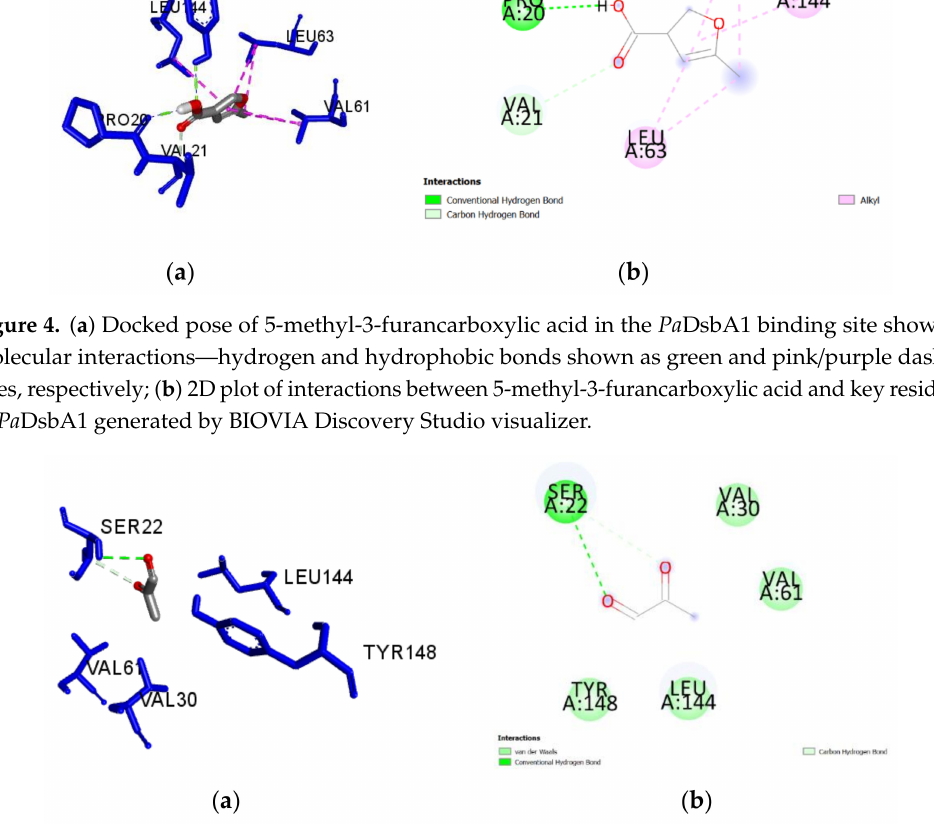
Figure 5. ( a ) Docked pose of methylglyoxal in the Pa DsbA1 binding site showing molecular interactions—hydrogen and hydrophobic bonds shown as green and pink / purple dashed lines, respectively; ( b ) 2D plot of interactions between methylglyoxal and key residues of Pa DsbA1 generated by BIOVIA Discovery Studio visualizer.